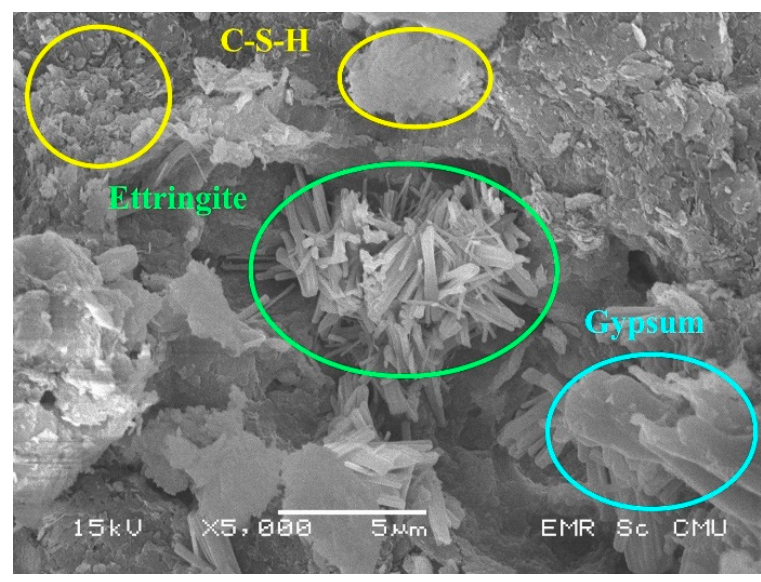
Figure 16. The SEM image of C3G3.